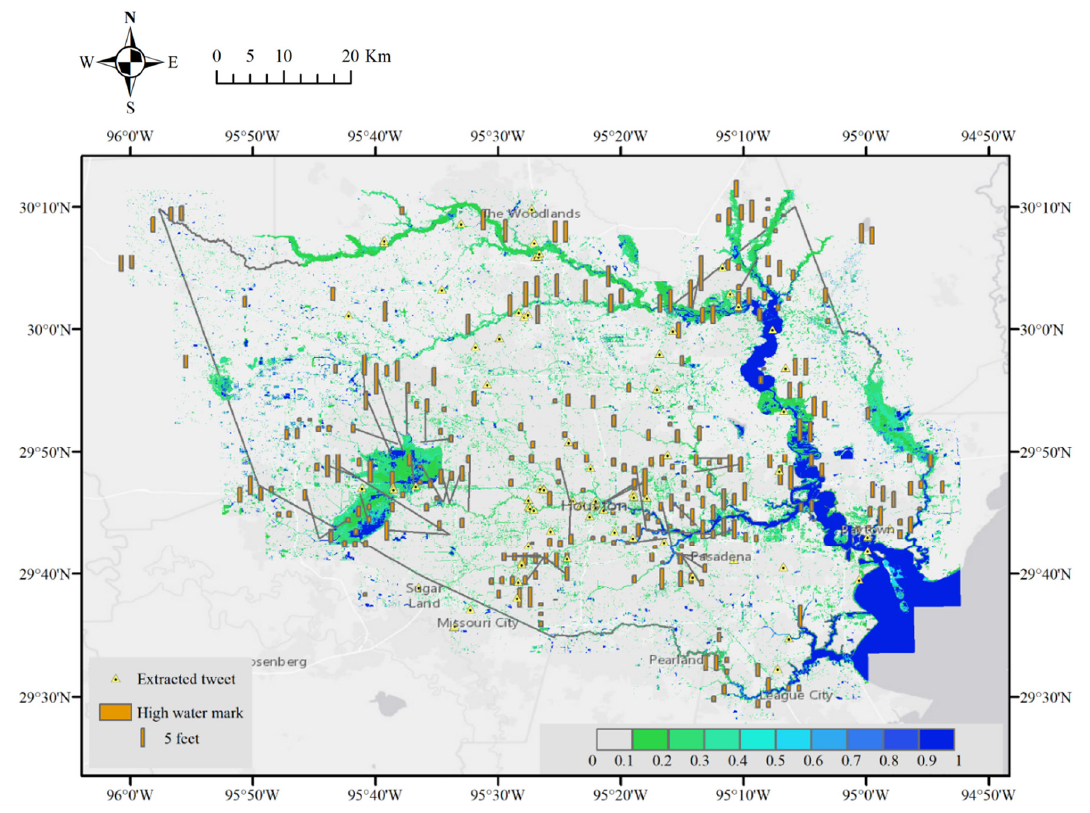
Figure 17. Extracted tweets and high water marks on top of the max-inundation probability from 14 August to 5 September when data are available.